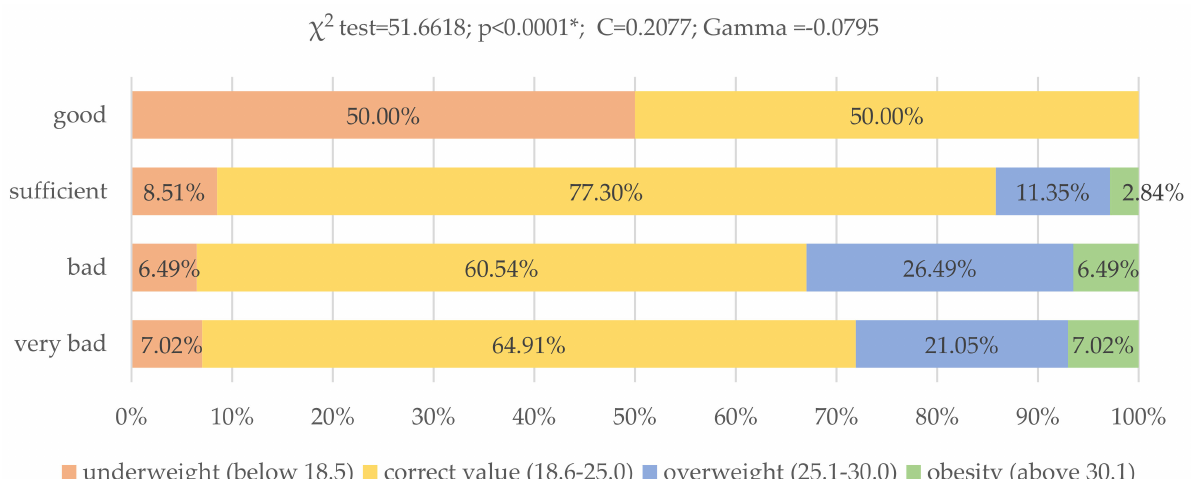
Figure 7. Assessment of nutritional behavior of young adult Poles and their level of BMI ( N = 399). * Statistically significant differences ( p < 0.05). Source: own study based on the